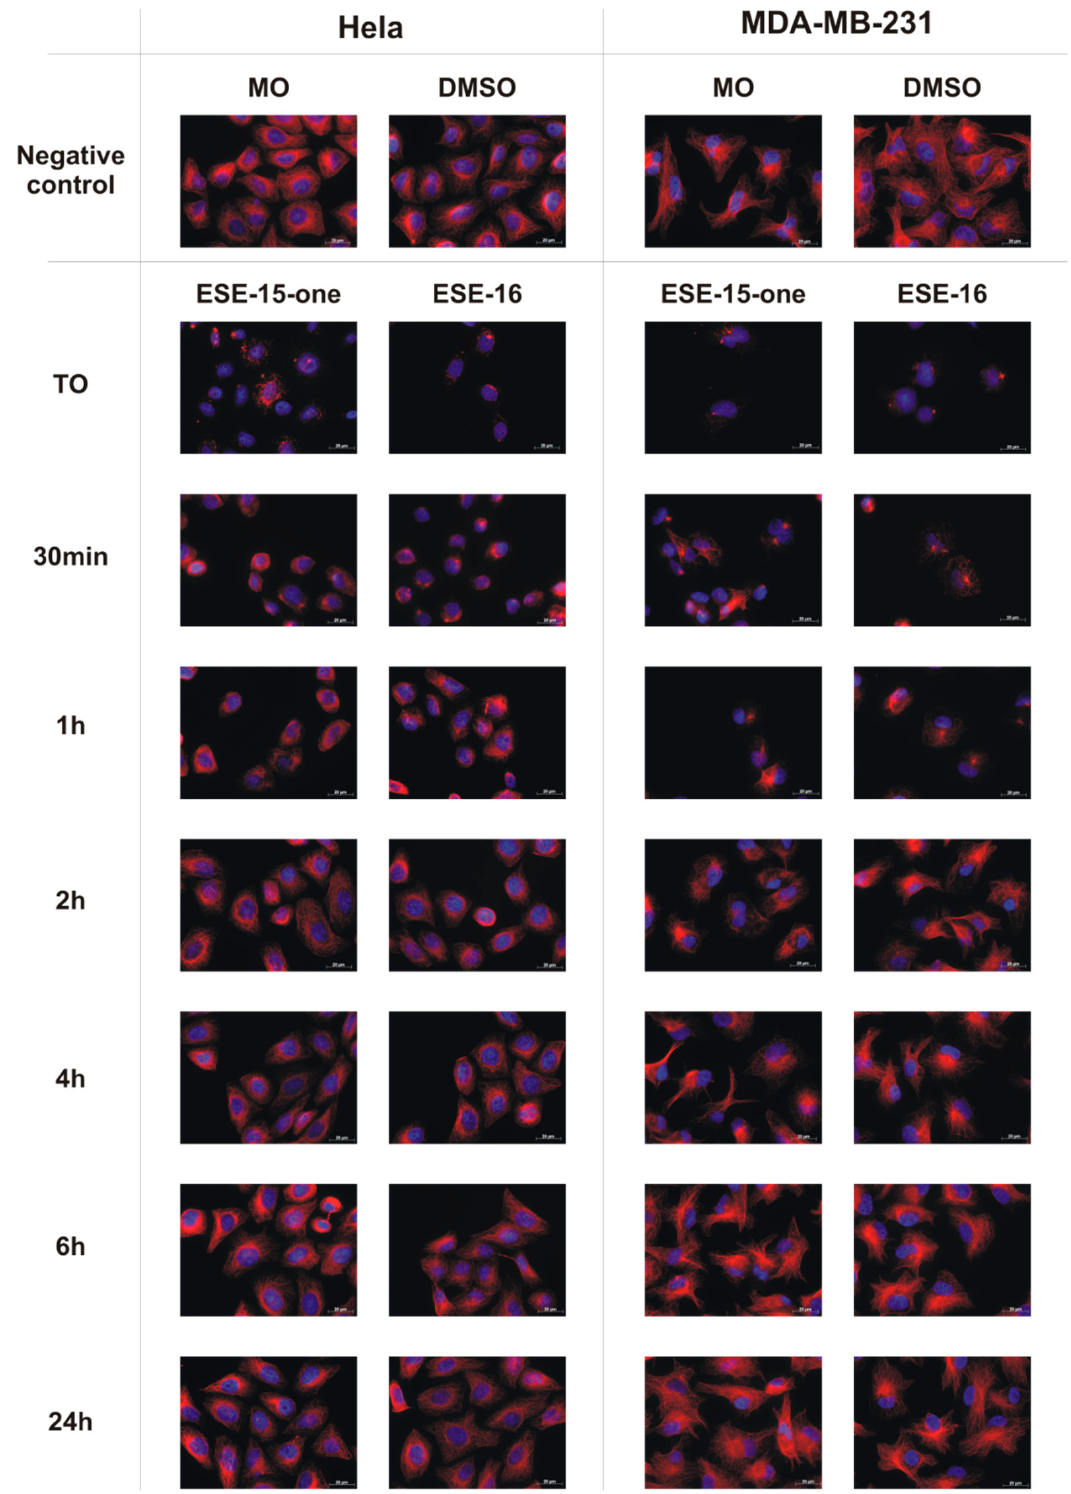
Figure 3. Immunofluorescence analysis of microtubule recovery in Hela and MDA-MB-231 cells after depolymerization with ESE-15-one and ESE-16 (63× magnification). Microtubules are stained red and nuclei are stained blue with DAPI. In both cell lines, full recovery of the microtubule network is observed over a 24 h time period once the molecules had been removed from the medium. Cells exposed to medium only (MO) and DMSO as a vehicle control demonstrate similar intact microtubule networks (Scale bar = 20 µm).